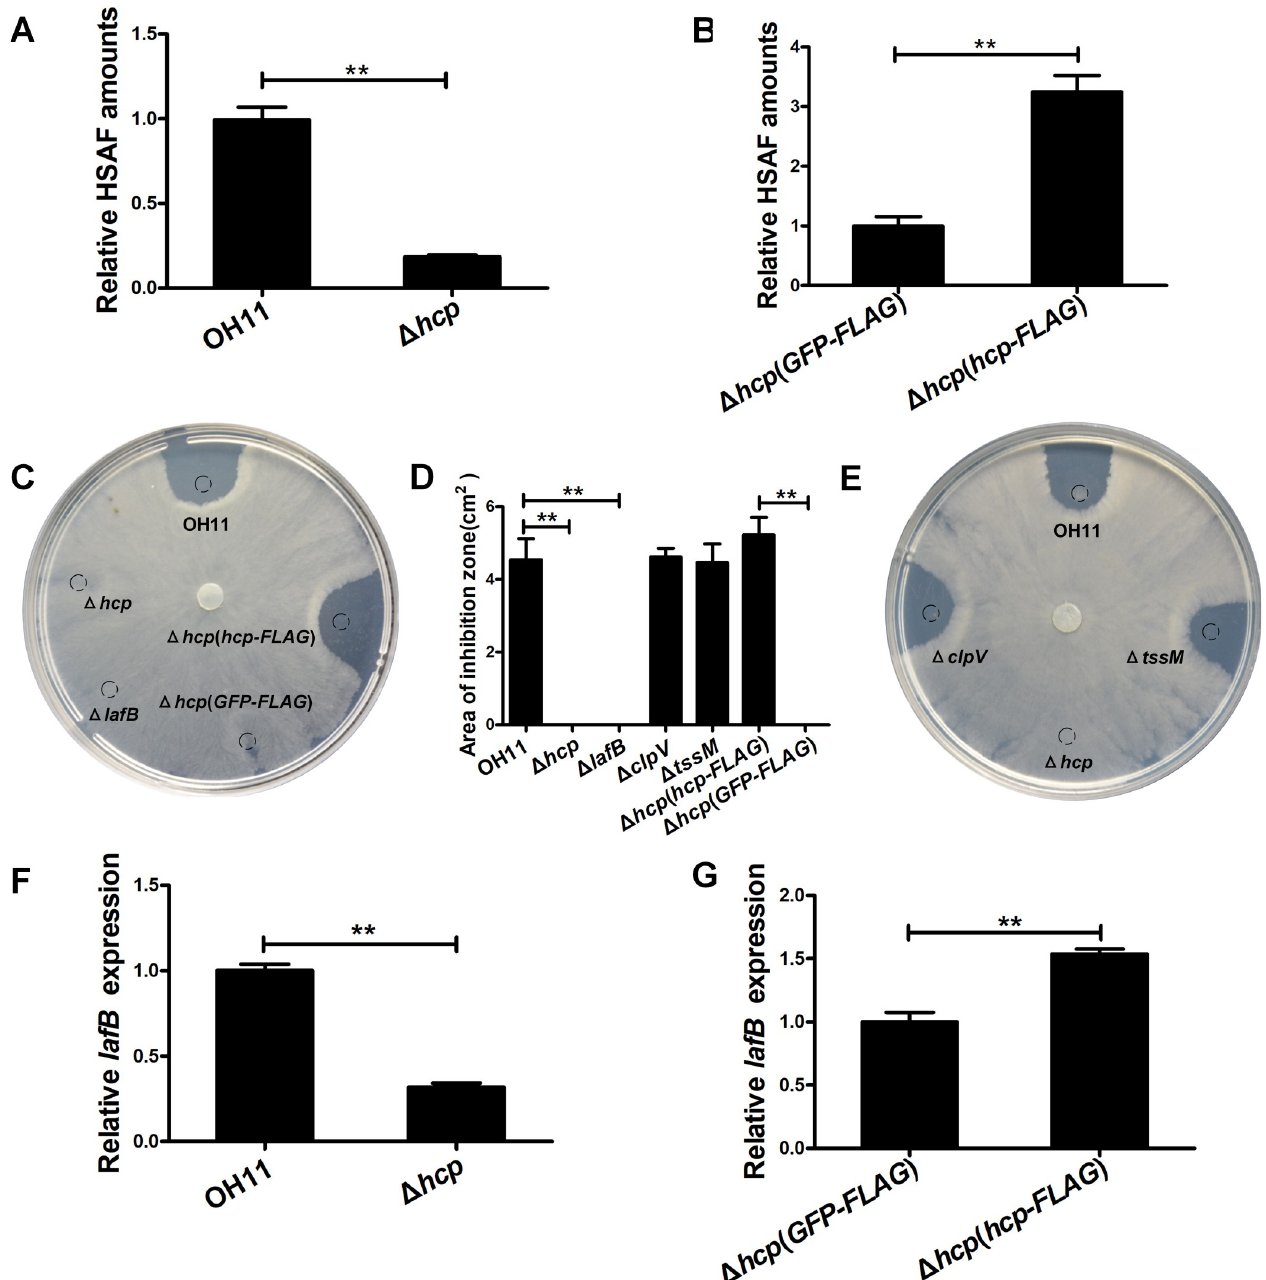
Fig 2. Hcp contributes to growth inhibition of P . capsica by regulating HSAF production in L . enzymogenes . (A-B) Relative HSAF production. Bacteria were grown in 1/10 TSB without gentamycin—strains OH11 and Δ hcp ( A ), or with gentamycin—strains containing plasmids expressing either GFP-FLAG and hcp- FLAG ( B ). (C-E) Plating assay showing inhibition of P . capsici growth by the HSAF extracts from L . enzymogenes ( C, E ), and statistical analysis of inhibition zones ( D ). Dash-lined circles indicate the sites of HSAF spotting. Lengths of the longest axis and shortest axis of the inhibition zones were determined and averaged as the radius, R, according to an earlier report [33]. The inhibition zones were calculated by using the formula π × R 2 . Average data from three experiments are presented, ± SD. �� P < 0.01. ( F-G ) Relative lafB mRNA abundance measured by qRT-PCR in the Δ hcp mutant and wild-type, OH11, grown in 1/10 TSB without gentamycin ( F ), and in the Δ hcp mutant containing the plasmid-expressed GFP-FLAG and hcp-FLAG , grown in 1/10 TSB with gentamycin ( G ). Average data from three experiments are shown, ± SD. �� P < 0.01. For strain description, see legend to Fig 1.